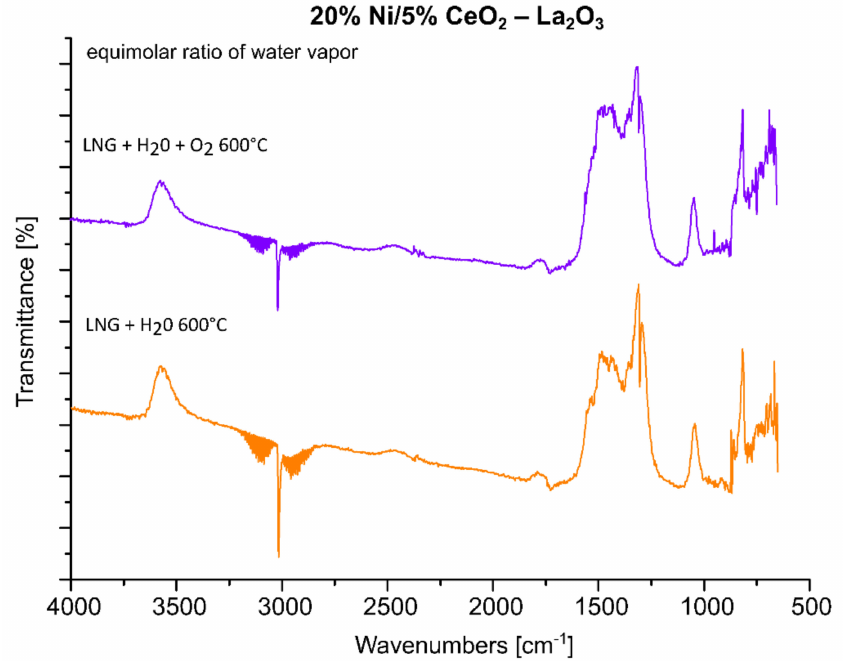
Figure 13. In situ IR spectra under steam and oxy-steam reforming of LNG conditions at 600 ◦ C recorded for the 20% Ni/5% CeO 2 –La 2 O 3